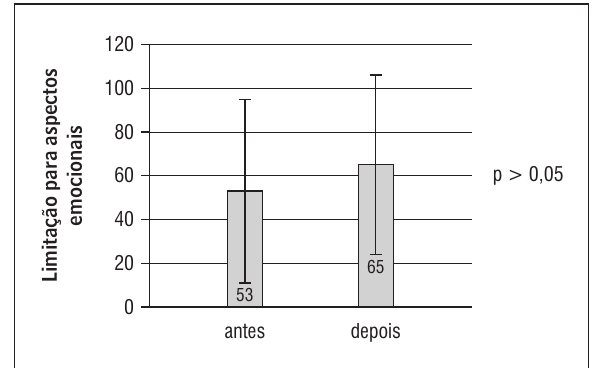
Figura 7 - Média e desvio-padrão da limitação por aspectos emocionais dos pacientes antes e depois do pro- tocolo fisioterapêutico (n = 27; p >